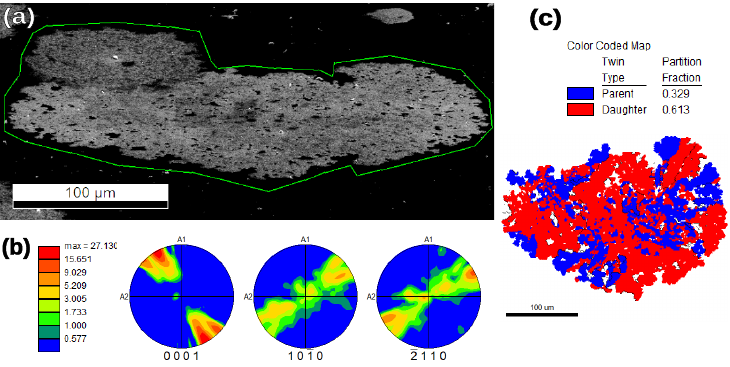
Figure 7. EBSD analysis of a x = 2.5% sample. Indexing is made with the α -quartz unit cell. ( a ) 71 ◦ - tilted SEM image of a crystalline, non-dendritic region. ( b ) ODF plotted in three different pole figures. The [0001] figure shows a certain orientation, tending to a single in-plane direction. ( c ) EBSD map of the region, showing that the entire formation is 200–300 µ m in size; the twinned regions are smaller. There are some grain boundaries present (black lines). The distribution of Dauphiné twins is more disorderly than in the dendritic